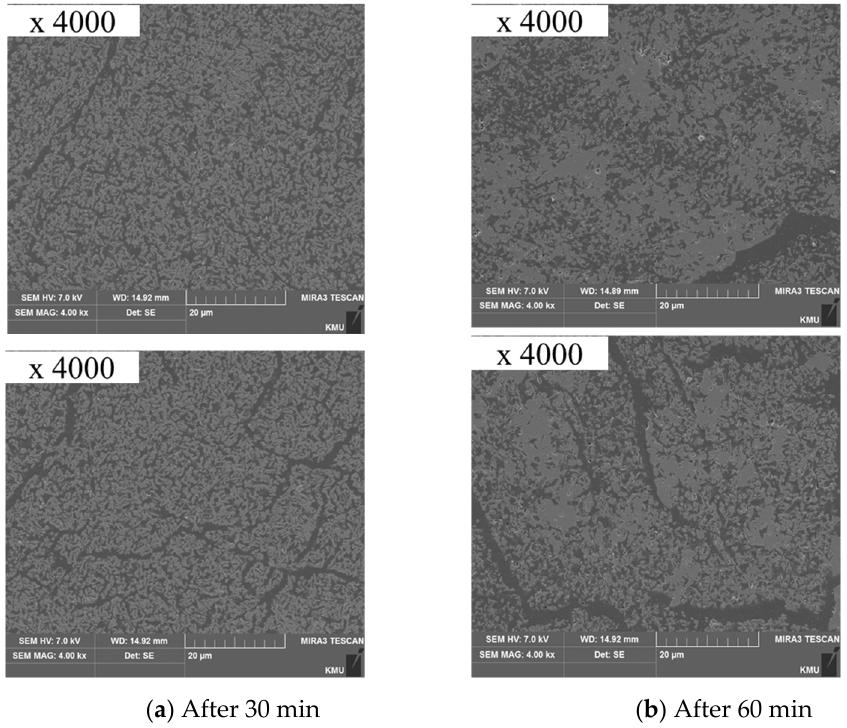
Figure 11. SEM images of the (NH 4 ) 4 Mo 5 O 17 after the direct hydrogen reduction at 575 °C.